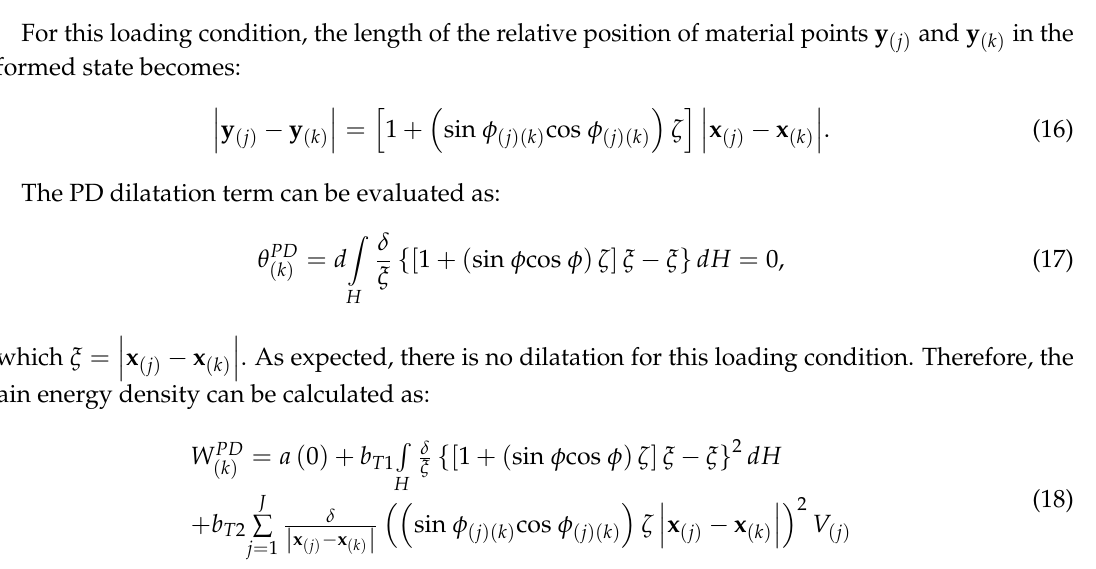
Figure 3. Simple shear loading condition (x: crystal orientation direction).